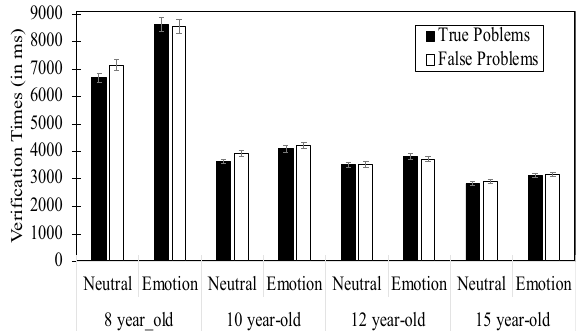
Figure 1. Age-related decrease in deleterious effects of emotion on children’s arithmetic